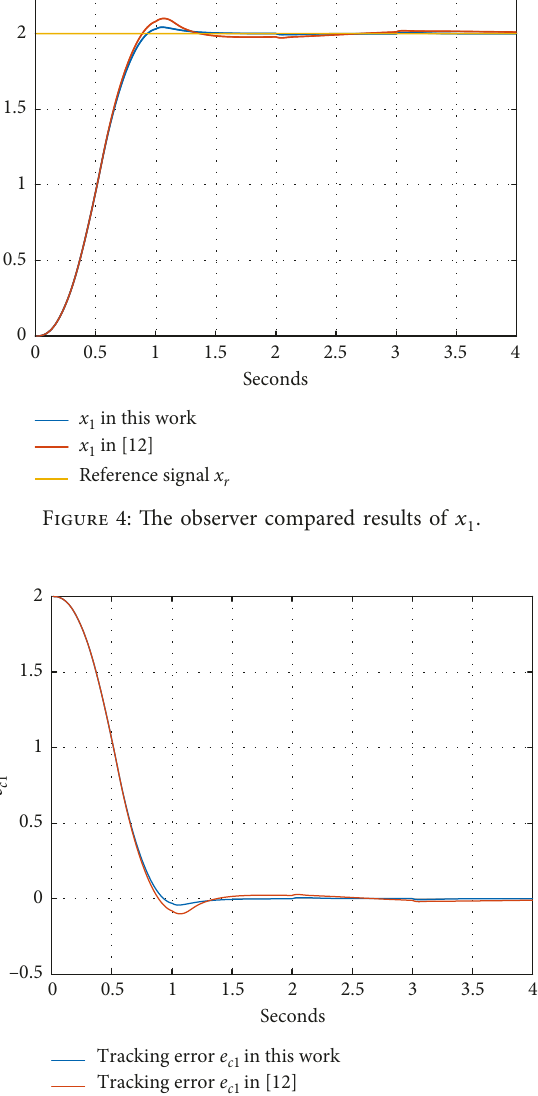
Figure 5: The observer compared results of e